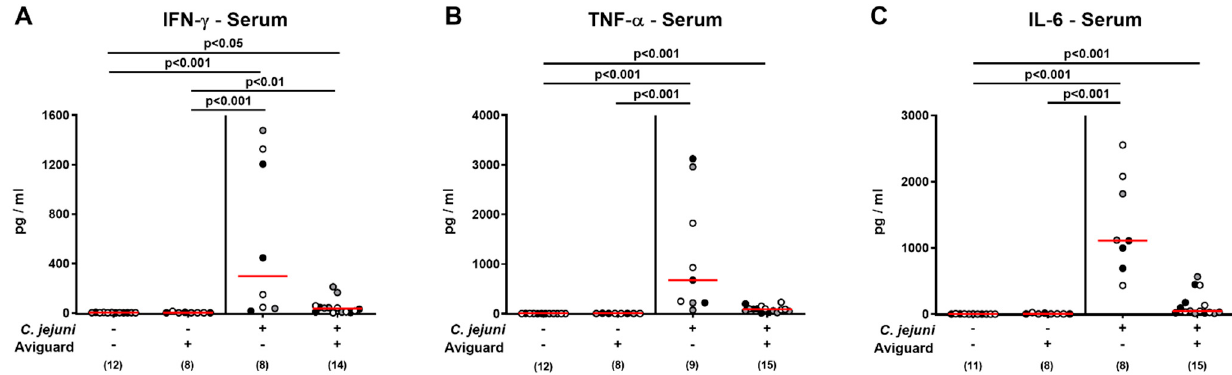
Figure 8. Aviguard ® treatment and systemic pro-inflammatory cytokine secretion in C. jejuni -infected microbiota-depleted IL-10 − / − mice. Following C. jejuni strain 81-176 infection on days 0 and 1, microbiota-depleted IL-10 − / − mice were perorally treated with Aviguard ® or placebo on days 2, 3, and 4. On day 6 post-infection, ( A ) IFN- γ , ( B ) TNF- α , and ( C ) IL-6 concentrations were measured in serum samples. Medians (red bars), significance levels ( p values) calculated by the Kruskal–Wallis test and Dunn’s post-correction, and numbers of analyzed mice (in parentheses) are indicated. Data were pooled from three independent experiments (as indicated by black, white, and gray circles).